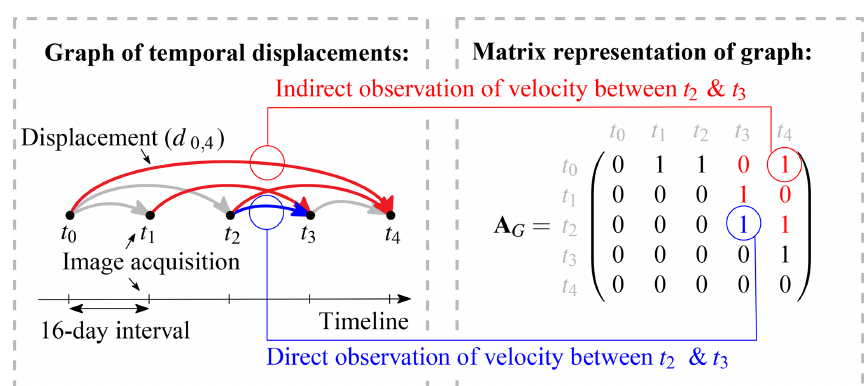
Figure 2. Graphical and matrix representation of a network. Here acquisition pairs within a network are illustrated and written down in an adjacency matrix ( A G ). The dark gray squares indicate acquisitions within a period to be estimated. The connecting colors symbolize an open (red) or closed (blue) selection of displacements to be used for the velocity estimation over this period ( v ).